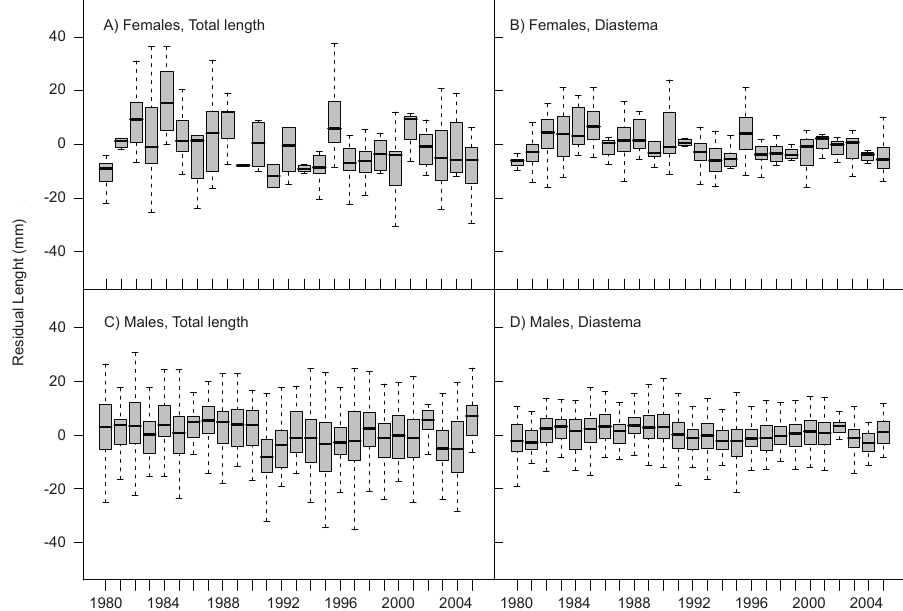
Fig. 3. Trends in jawbone size for males and females in the La Poile herd, 1980-2005, based on residuals from Gompertz growth equations. The boxes contain the 25th to 75th percentiles of the data and the hori- zontal line indicates the median. The whiskers extend to 1.5 times the inter-quartile